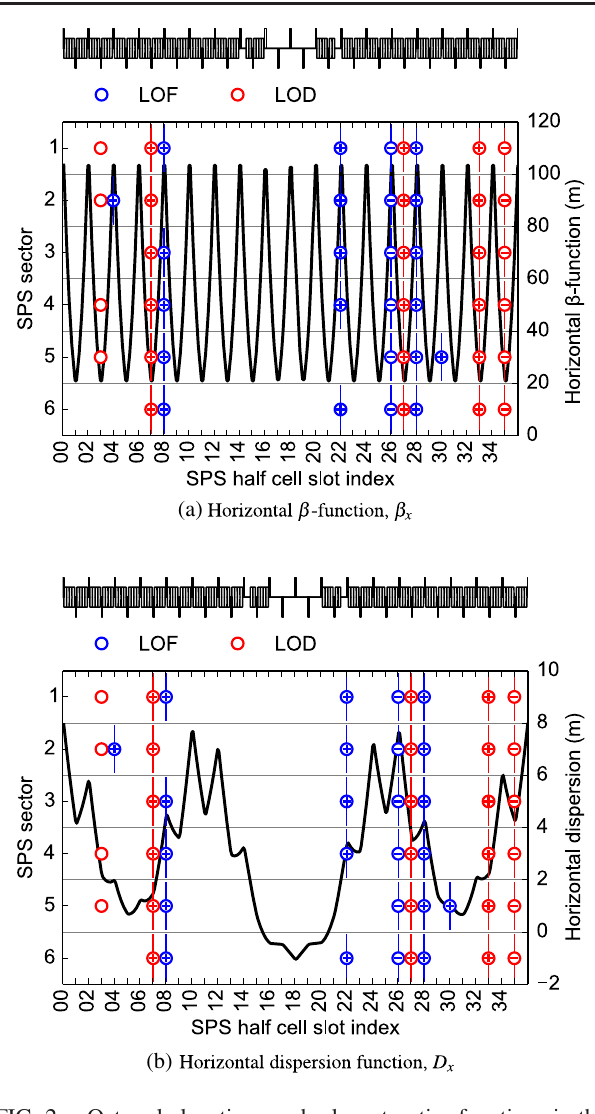
FIG. 2. Octupole locations and relevant optics functions in the SPS lattice per sector after recent modifications to the LOF and LOD powering configuration